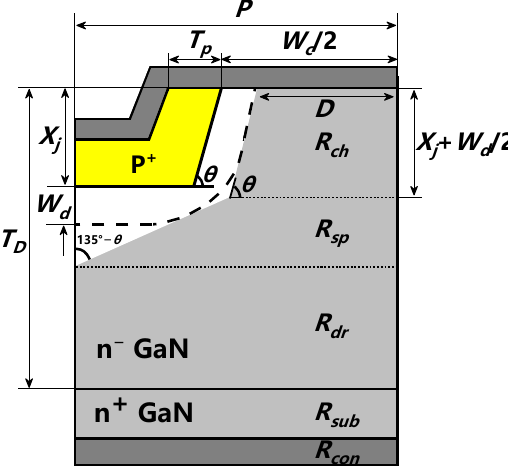
Figure 9. Current path in TJBS diode used for on-state analysis.